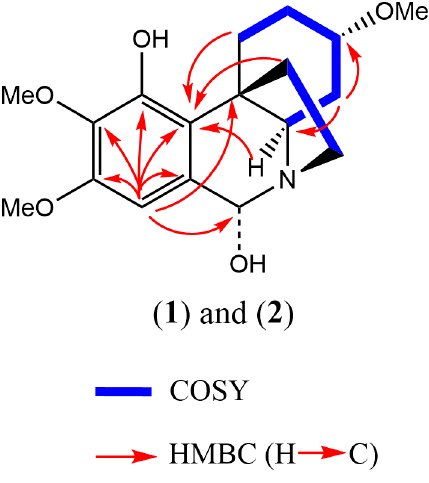
Figure 4. Key HMBC and COSY correlations for two 6-epimers of 6-hydroxyhippeastidine.